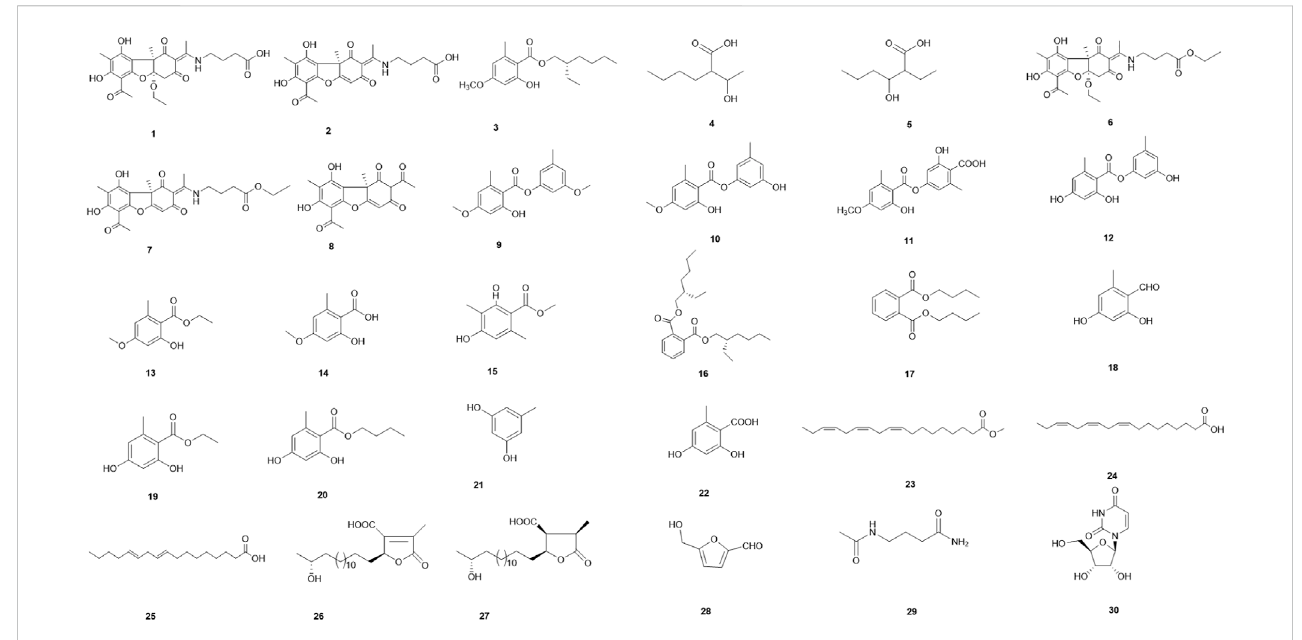
FIGURE 1 Chemical structures of compounds 1 – 30